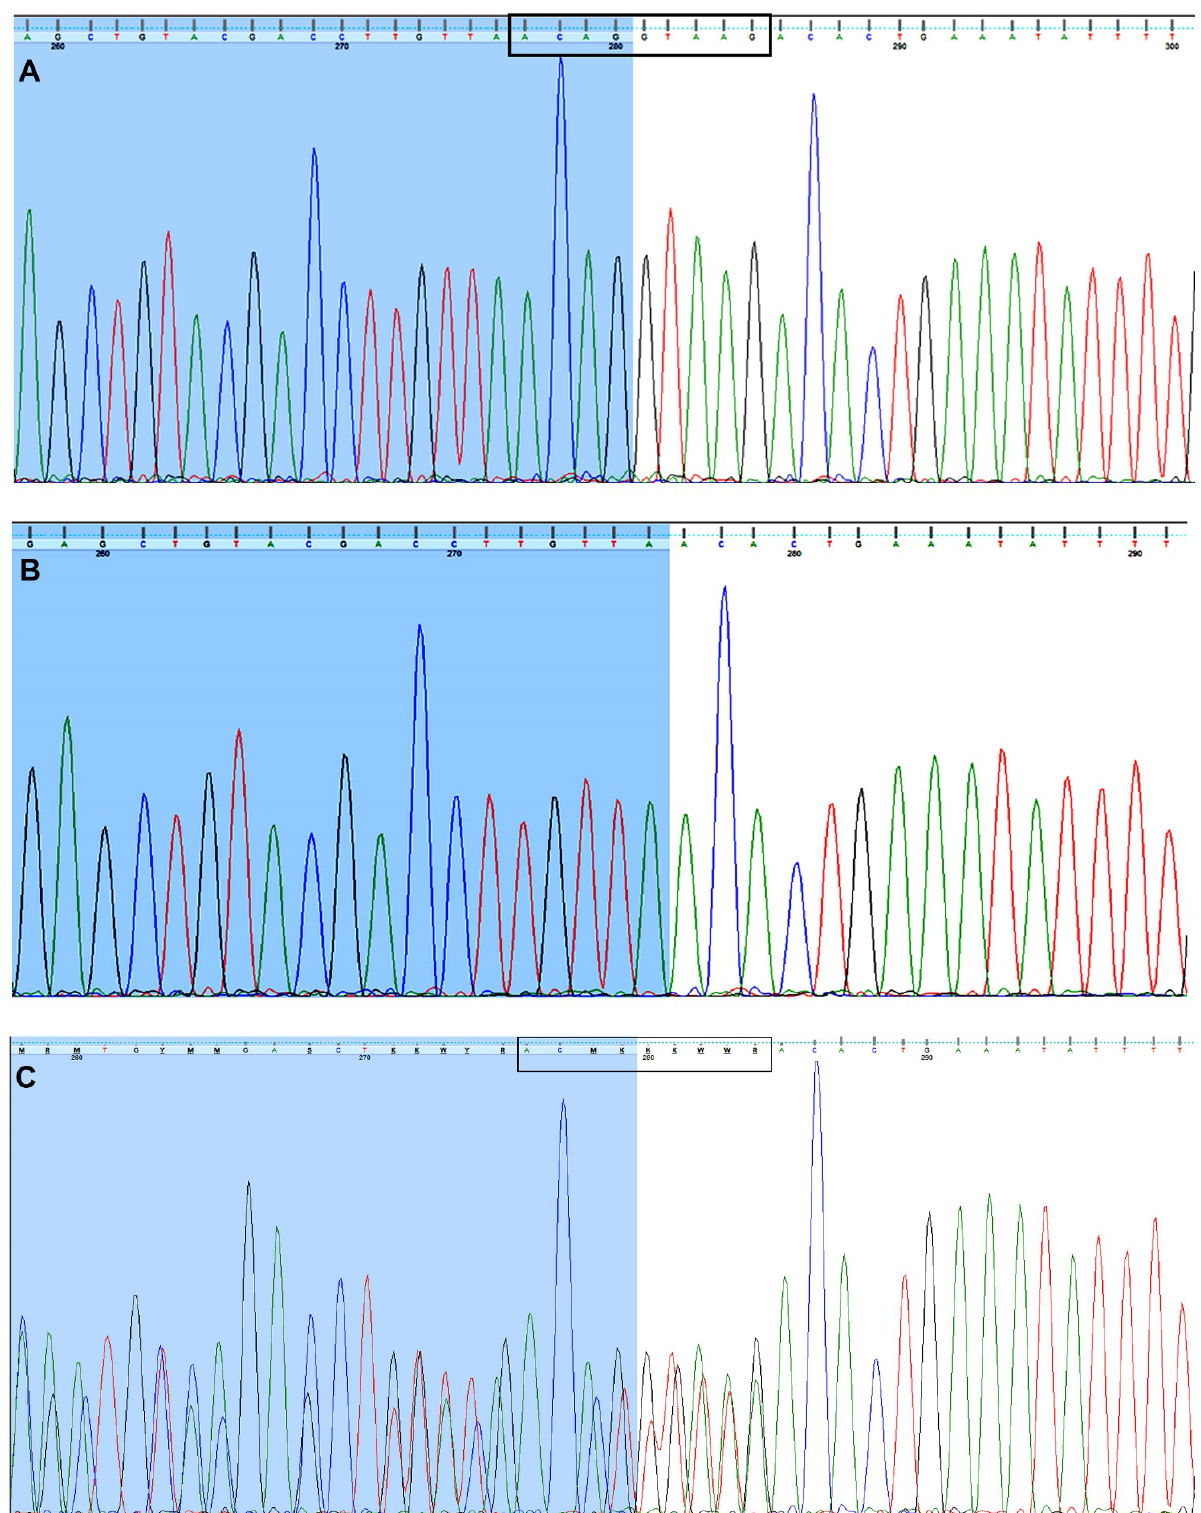
Figure 1. The Sanger-based sequencing. The sequence traces of ( A ) an unrelated person (a control sample), ( B ) the child’s DNA carrying the homozygous 9-base-pair deletion (NG_013346.1:g.10233_10241delACAGGTAAG) encompassing the exon 3/intron 3 junction within the FUCA1 sequence and ( C ) the girl’s parents. The parents are heterozygous for 9-bp deletion (NG_013346.1:g.[10233_10241delACAGGTAAG]+[=]). ( C ) The bases at the overlapping nucleotide positions are written in the IUPAC code. The sequence of the 3’ end of exon 3 is marked in blue ( A – C ).